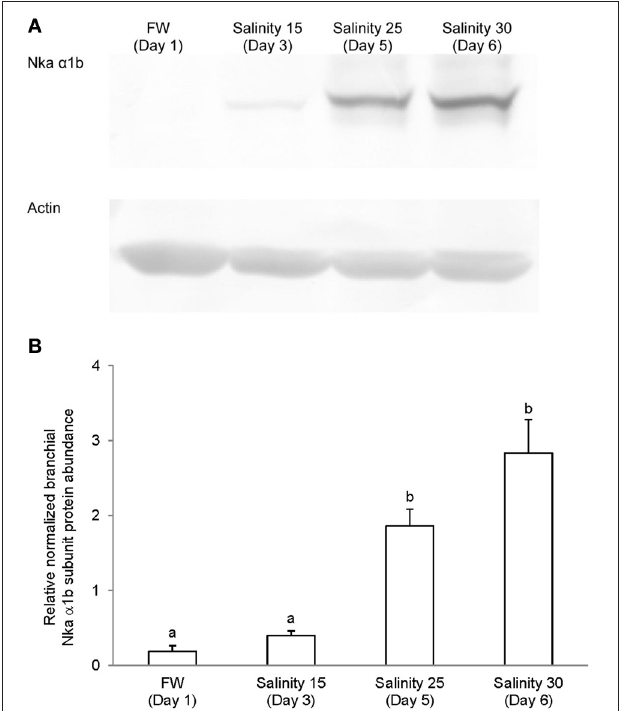
FIGURE 9 | Protein abundance of Na + /K + -ATPase α 1b (Nka α 1b) in the gills of Anabas testudineus kept in freshwater on day 1 (FW; control), or after 24h of exposure to salinity 15 on day 3, salinity 25 on day 5, or salinity 30 (seawater) on day 6 during a progressive acclimation from freshwater to seawater. (A) Immunoblotsof Nka α 1b and actin. (B) The intensity of the Nka α 1b protein band normalized with respect to actin. Results represent mean + S.E.M. ( N = 4). Means not sharing the same letter are significantly different ( P < 0 . 05).